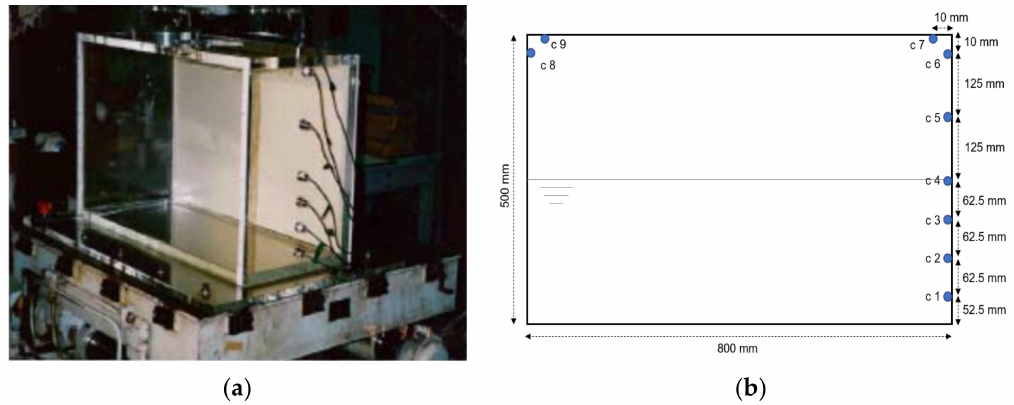
Figure 4. Experiment apparatus ( a ) and sensor locations ( b ) for the sloshing model